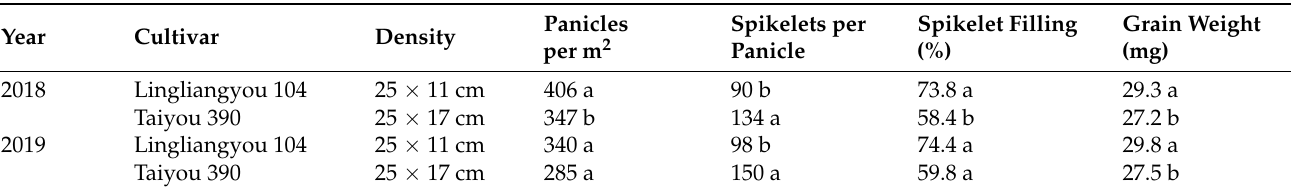
Table 2. Yield components of two growth-duration rice cultivars under two planting densities in 2018 and